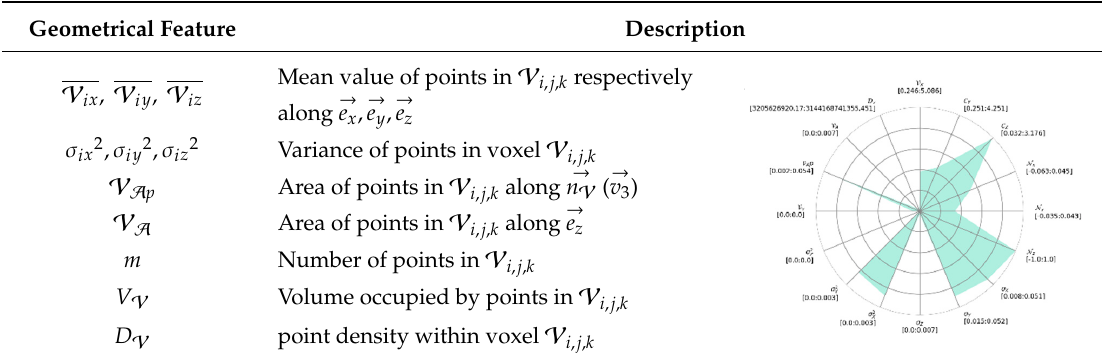
Table 2. Geometrical features part of the SF1 feature set. Table 2: Geometrical features part of the SF1 feature set.